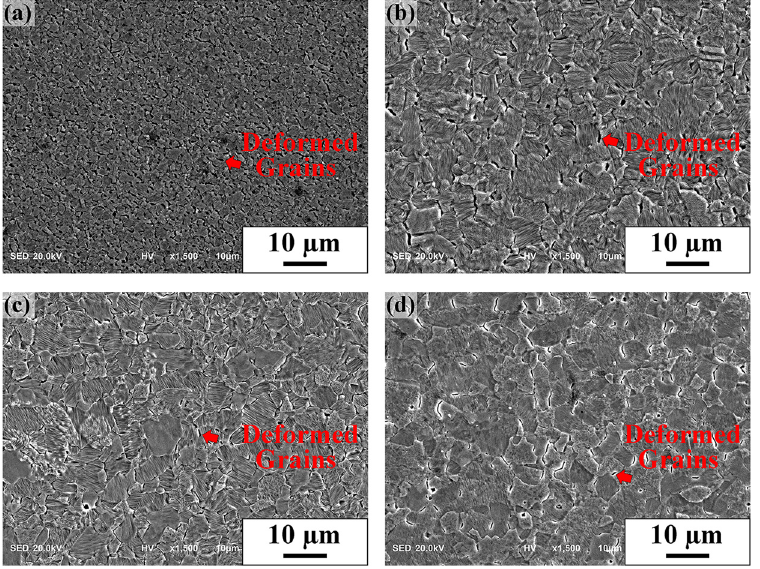
Figure 10: Microstructures in the SZ of the HEA at ( a ) 200, ( b ) 300, ( c ) 400, and ( d ) 500 rpm after chemical